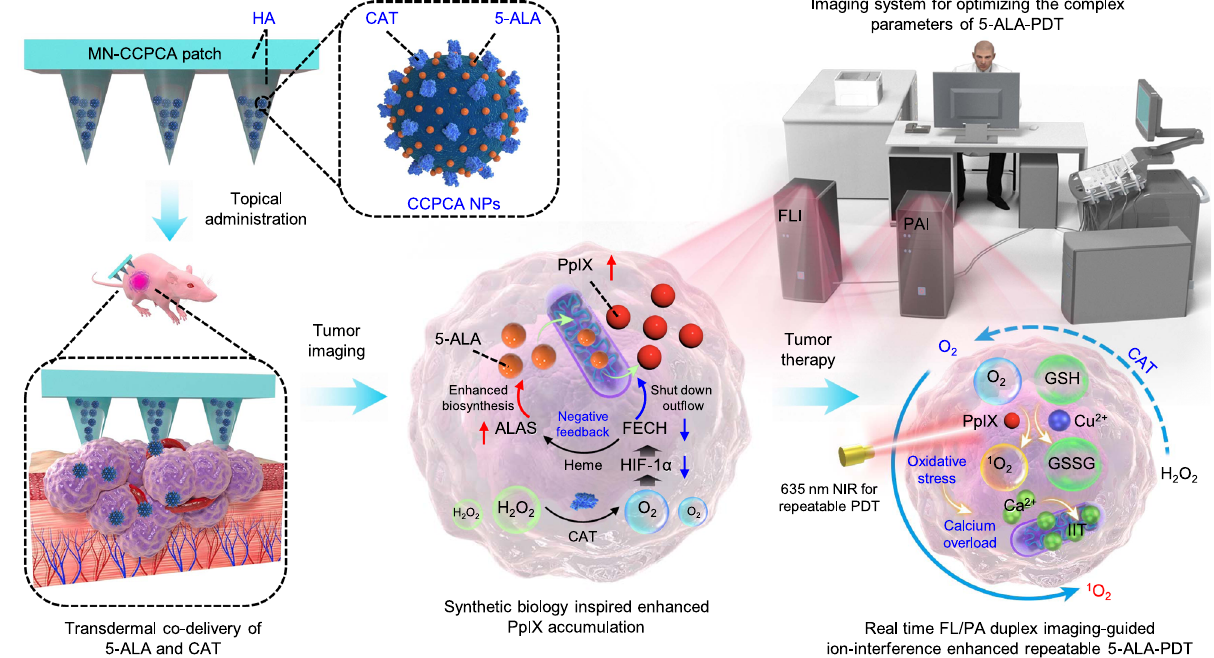
Fig. 1 | In vivo real-time companion theranostics by MN-CCPCA patch. 5-ALA and CAT were directly delivered to the tumor site by the transdermal co-delivery patch. The MN-CCPCA patch continuously catalyzed hydrogen peroxide (H 2 O 2 ) into